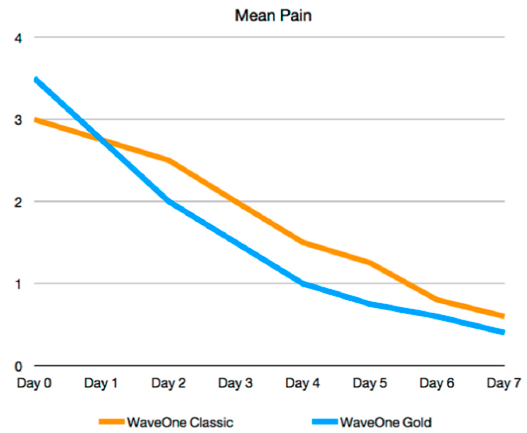
Figure 2. Mean pain curve ( p = 0.43).